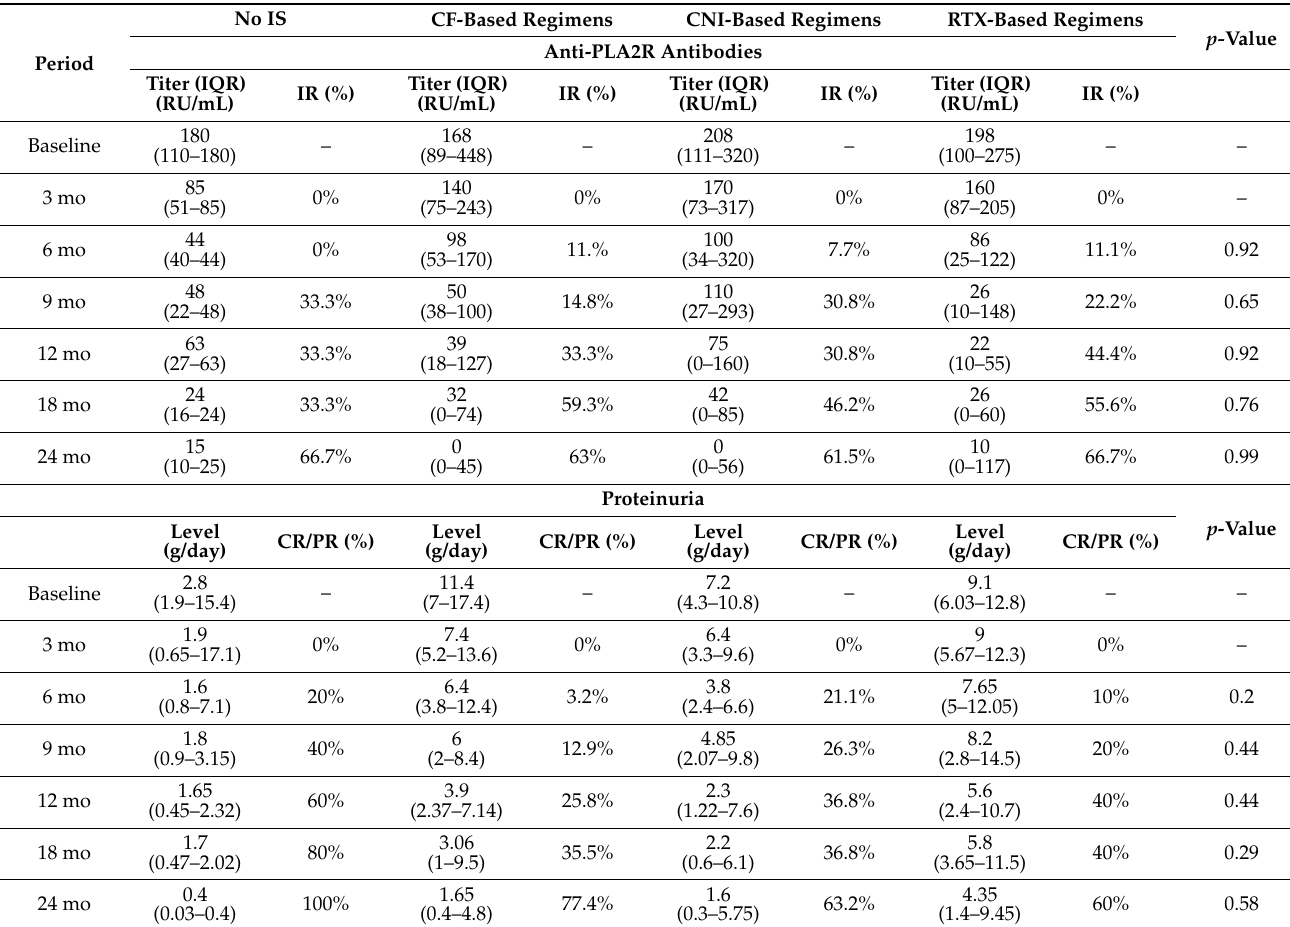
Table 5. Evolution of anti-PLA2R antibody titer and 24 h proteinuria according to immunosuppressive regimen.